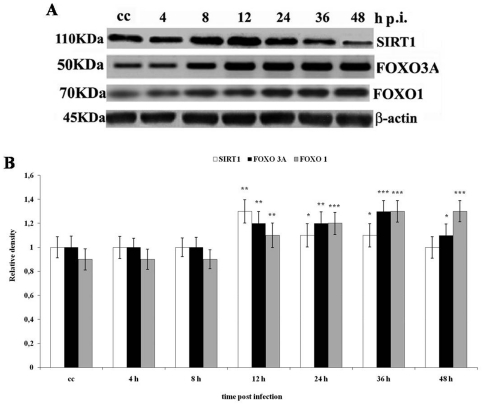
CCoV-II infection modulates the SIRT1, FOXO3 and FOXO1 proteins expression.(A) Whole-cell lysates were prepared from mock-infected (lanes cc, control cells) and infected cells at the indicated times. Western blot analysis was performed with antibodies specifically recognizing SIRT1, FOXO3A and FOXO1. β-actin was used as an internal loading control. The molecular weight (in KDa) of protein size standards is shown on the left hand side. Blot is representative of three separate experiments. (B) Densitometric analysis of blots relative to SIRT1, FOXO3A and FOXO1. The bars represent the mean ± SEM of the results from three separate experiments. Significant differences between CCoV-II-infected cells and control cells are indicated by probability P. *P <0.05, **P <0.01, and ***P <0.001.